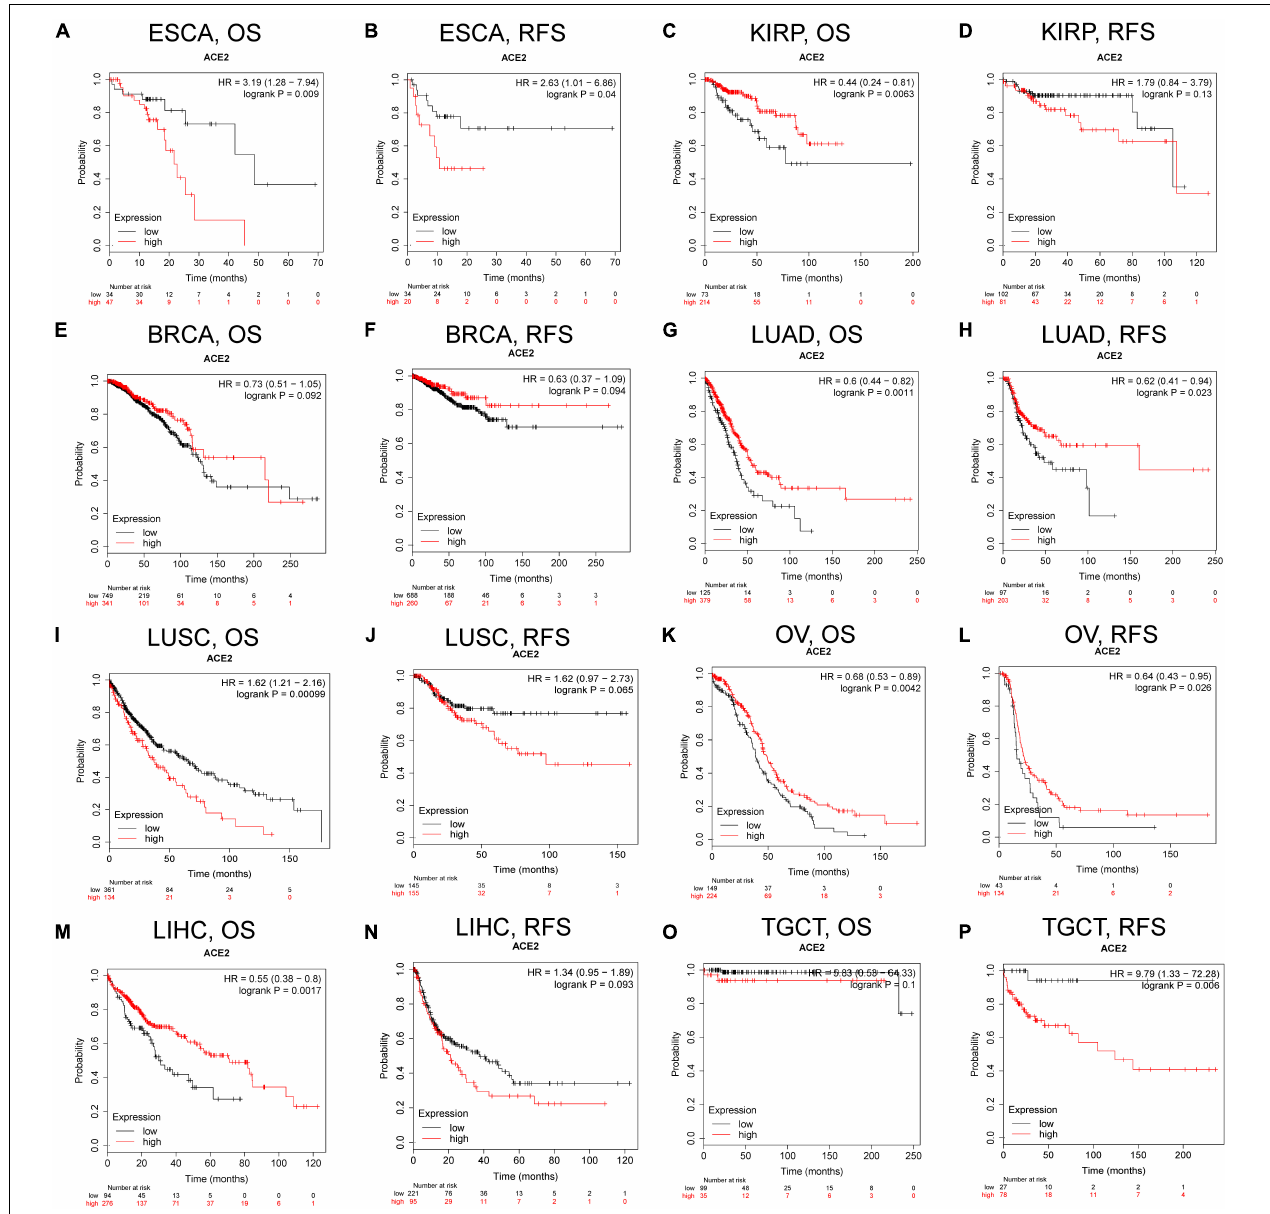
FIGURE 3 | Kaplan–Meier survival curves comparing the high and low expression of ACE2 in different types of cancer in Kaplan–Meier Plotter. OS and RFS of (A,B) esophageal carcinoma (ESCA), (C,D) kidney renal papillary cell carcinoma (KIRP), (E,F) BRCA, (G,H) LUAD, (I,J) LUSC, (K,L) OV, (M,N) LIHC, and (O,P) TGCTs. Red curve represents patients with high expression of ACE2. OS, overall survival; RFS, relapse-free survival.